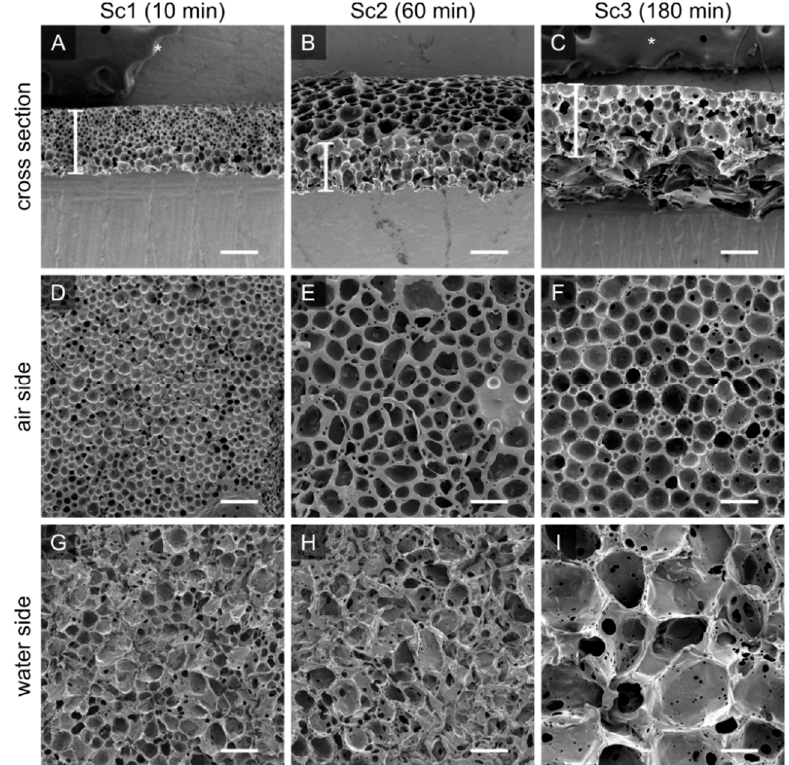
Figure 4. The porosity and pore size of the PTMC-dMA scaffolds is controlled by the floating time on the water before photo crosslinking. Scanning electron micrographs are shown for PTMC-dMA scaffolds Sc1, Sc2 and Sc3 with an initial concentration of 25% ( w / w ) and a time on water of 10 min ( A , D , G ), 60 min ( B , E , H ) and 180 min ( C , F , I ). Scale bars are 200 µ m. The asterisk (*) indicates the carbon tape that was used to stick the samples to the SEM